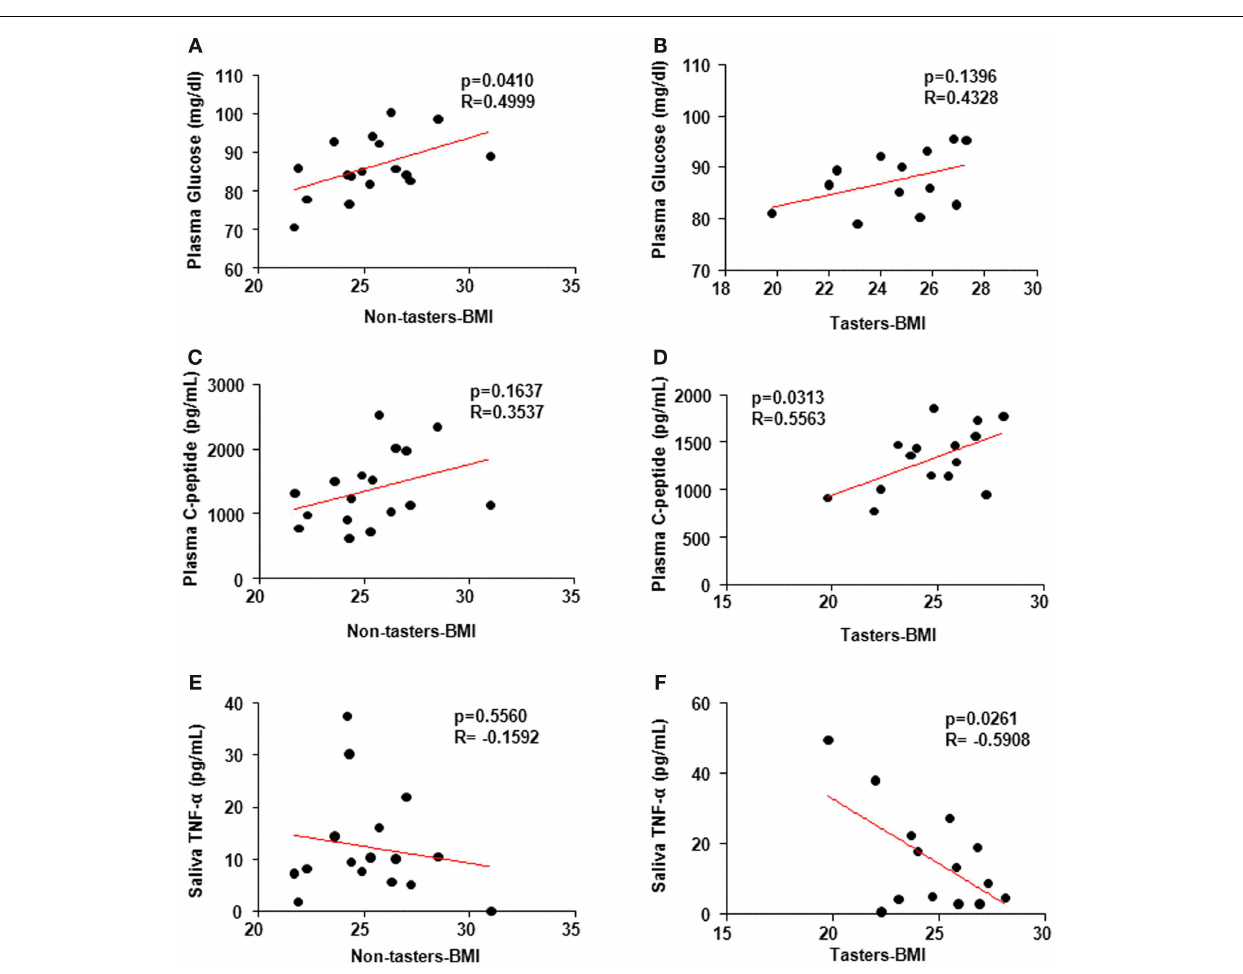
C-peptide was correlated with BMI in tasters but not non-tasters (C,D) . Saliva TNF- α was reversely correlated with BMI in tasters but not non-tasters (E,F) . A value of p < 0.05 was considered statistically